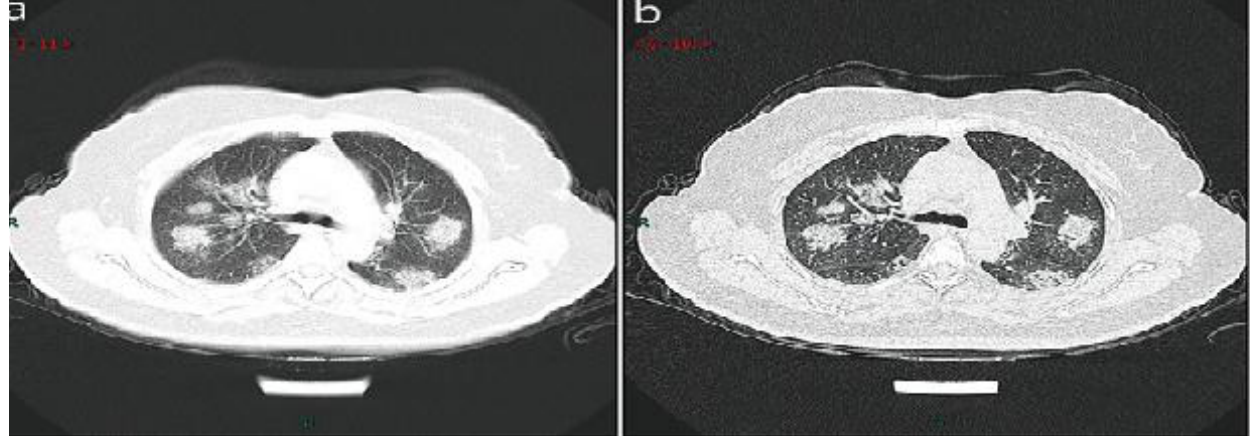
Figure 8: CT imaging of rapid progression stage. A 50 years old female with anorexia, fatigue, muscle soreness, nasal congestion and runny nose for 1 week, sore and itching throat for 2 days. Laboratory test: increased erythrocyte sedimentation rate (25 mm/h), normal white blood cells (4.08 × 10 9 /L), decreased lymphocytes (0.96 × 10 9 / L), increased C-reaction protein (60.8 mg/L). Imaging examination: a (thin layer CT) and b (high-resolution CT) showed multiplepatchy and light consolidation in both lungs and grid-like thickness of interlobular